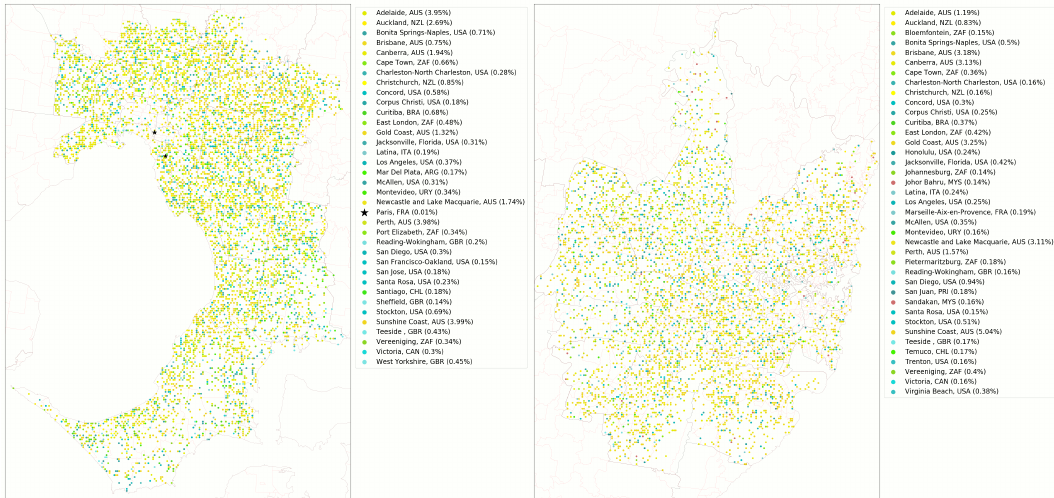
Figure 5. Predicted similar cities using the GSV-BSV neural network (filtering out probabilities lower than 50%). Top predicted cities plotted (using Figure 2 colour scheme) for Melbourne evaluation locations ( left ) and Sydney ( right ). Predicted Paris locations marked with black